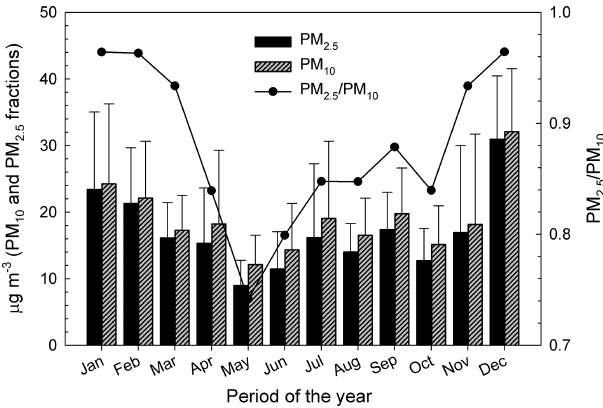
Figure 2. Patterns of the monthly arithmetic mean concentrations and standard deviations in the PM 10 , PM 2 . 5 , and PM 2 . 5 / PM 10 variables at Iasi, north-eastern